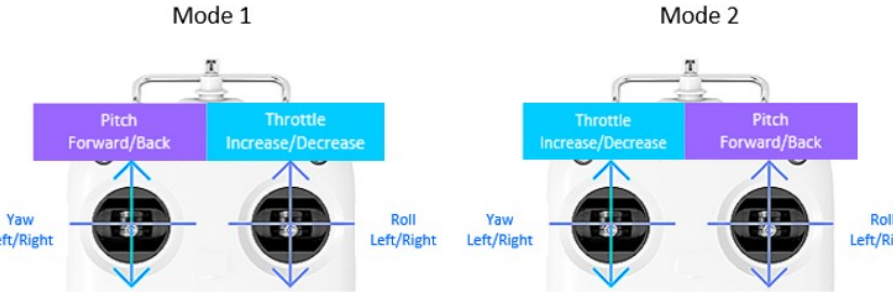
Figure 3. How to control a multi-copter using a twin stick controller.